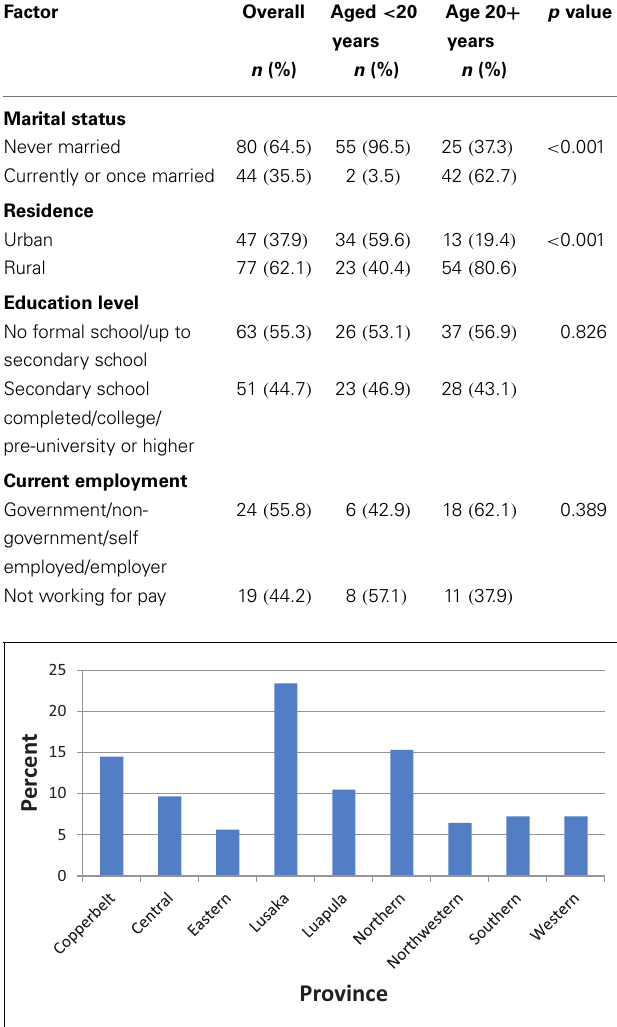
FIGURE 1 | Distribution of participants by province